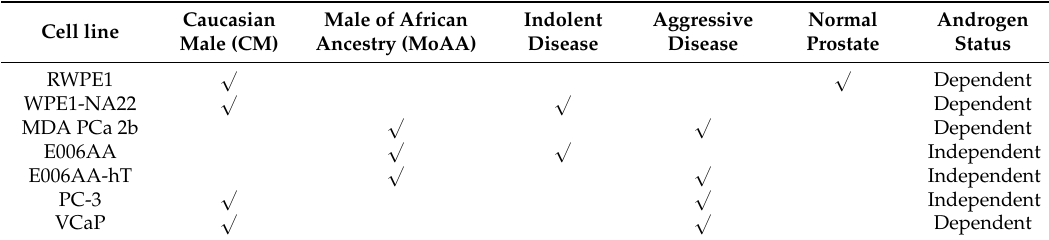
Table 1. Main characteristics of prostate epithelial cell lines used in this